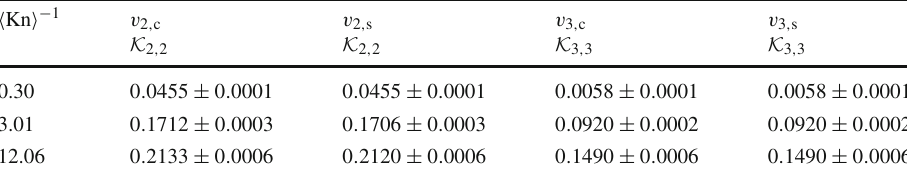
Table 6 Parameters of the linear-fit functions (3)–(4) for v v = 0 fm 2 , c / s and 3 , c / s at b